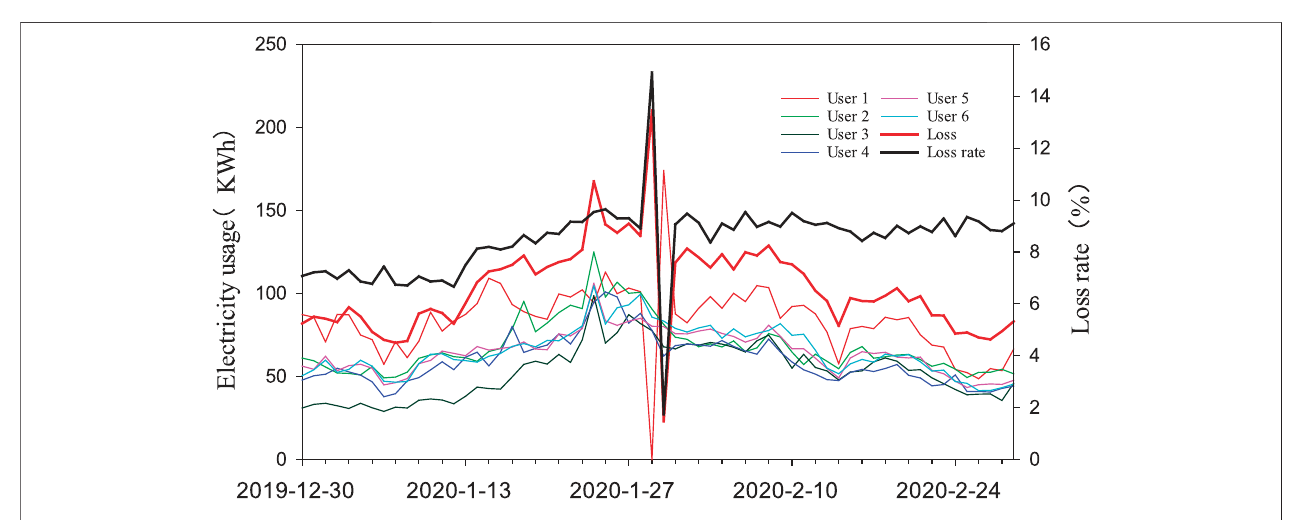
FIGURE 2 | Basic communication diagram of the distribution area.